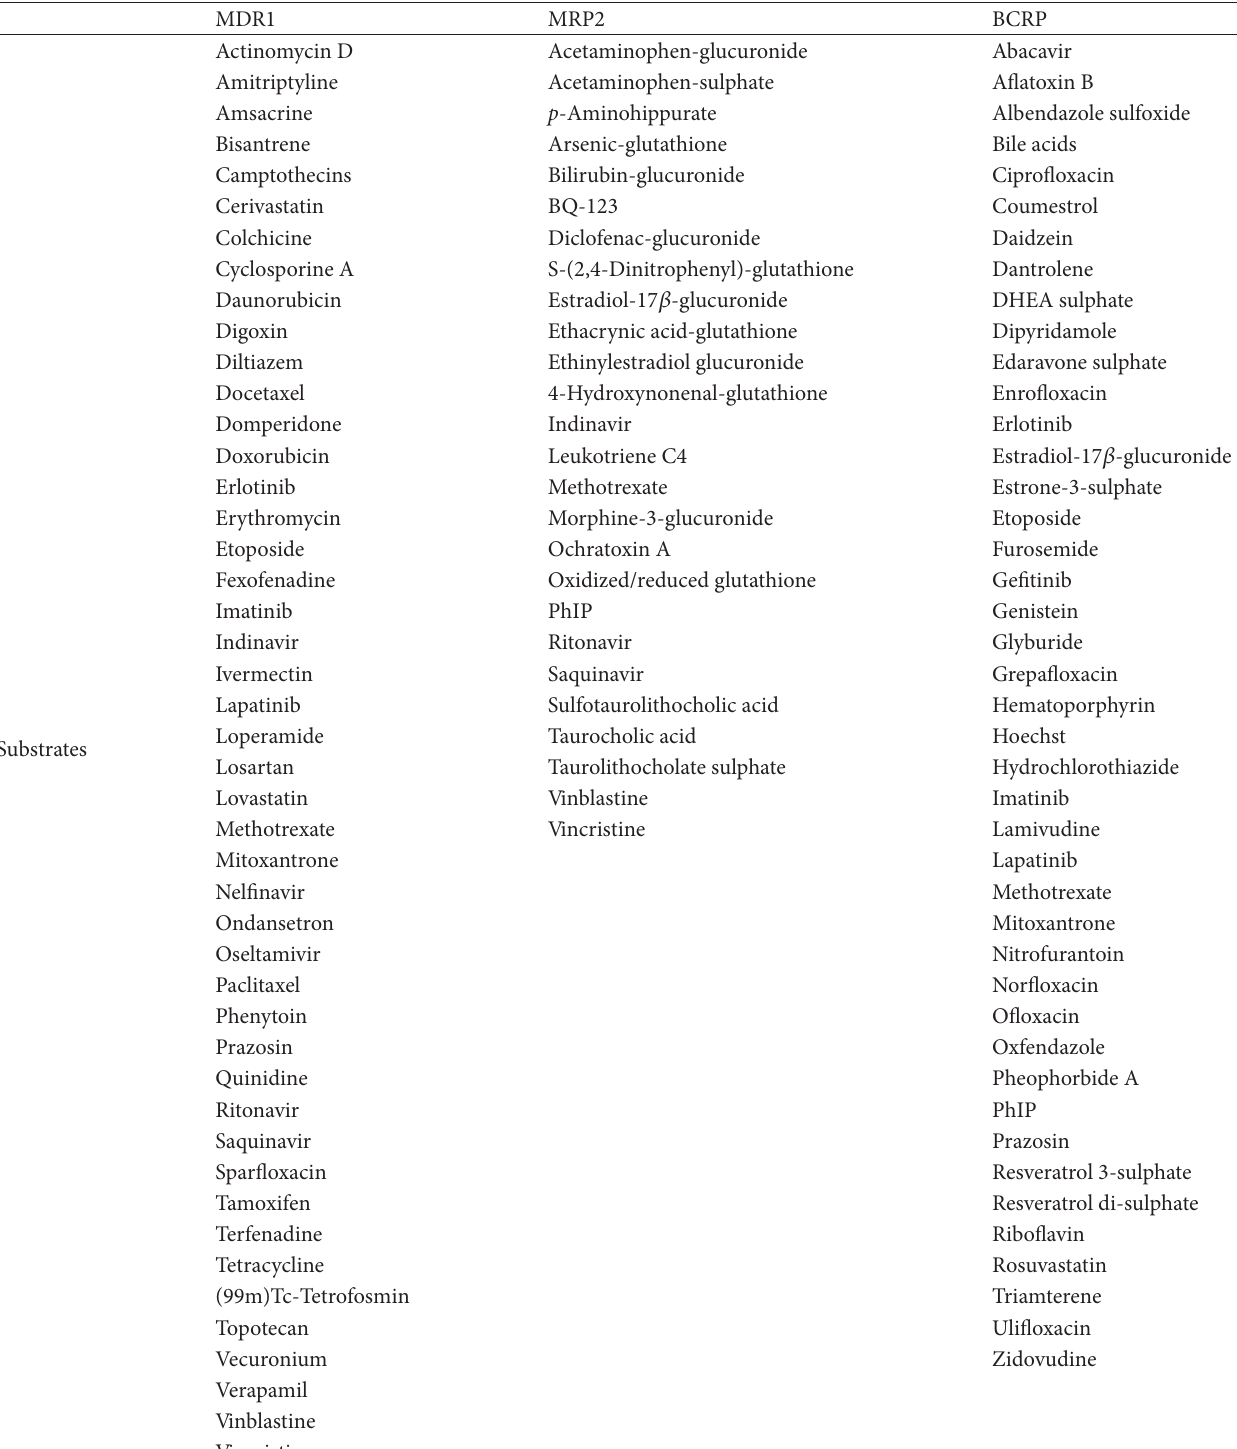
T 4: Identi�ed potential substrates of canalicular forms of ABC proteins �ith pharmacological